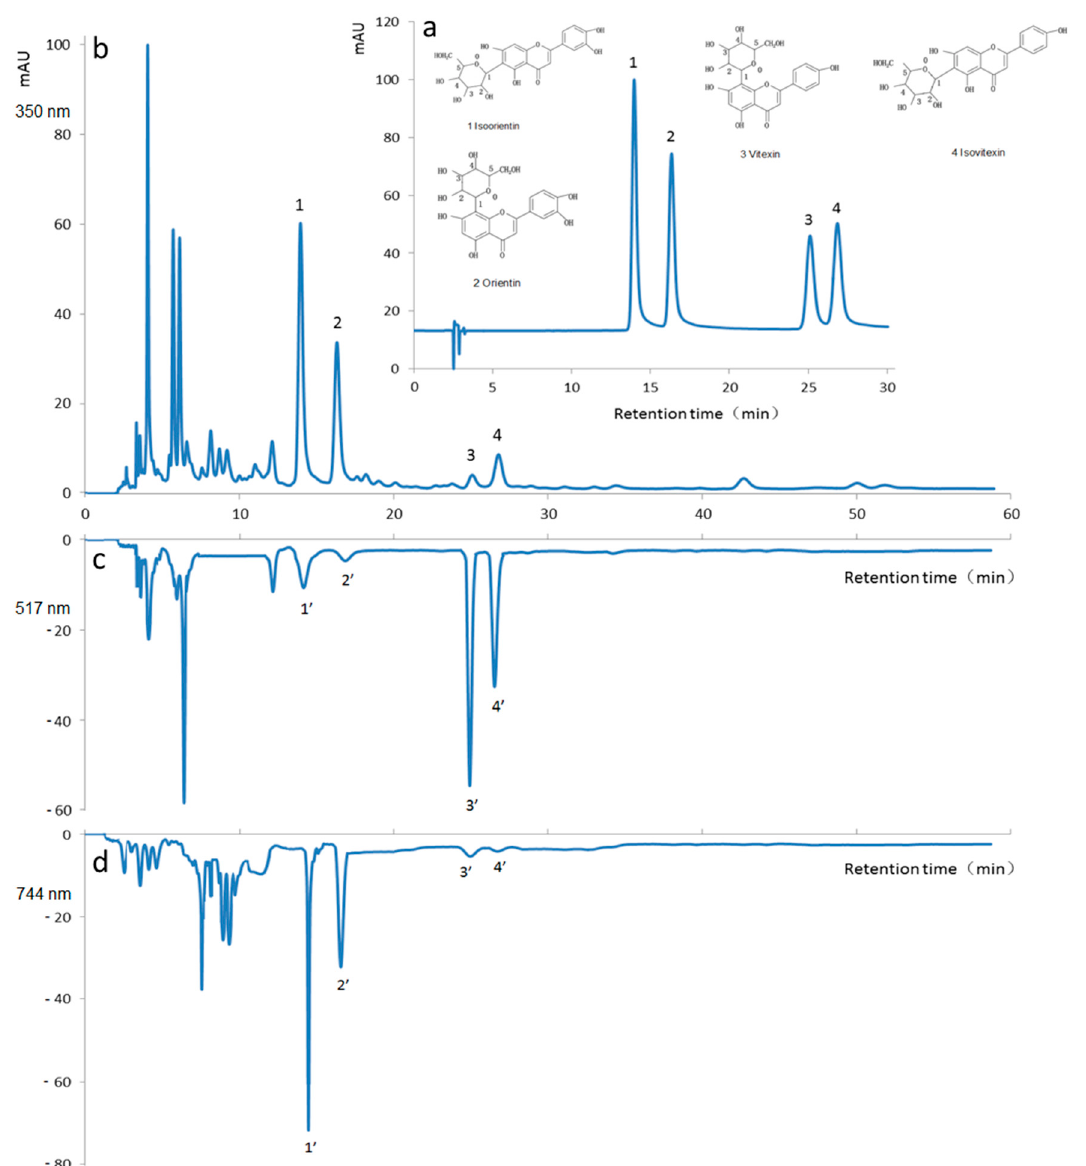
Figure 5. RP-HPLC chromatogram of the flavonoid standards and the on-line scavenging free radical capacity of the P. pubescens leaf sample. ( a ) RP-HPLC chromatogram of the bamboo flavonoid standards detected at 350 nm: 1 isovitexin, 2 orientin, 3 vitexin and 4 isoorientin; ( b ) RP-HPLC chromatogram of the P. pubescens sample detected at 350 nm; ( c ) On-line scavenging DPPH · free radical stability of the P. pubescens sample detected at 517 nm; ( d ) On-line scavenging ABTS + · free radical stability of the P. pubescens sample detected at 744 nm.